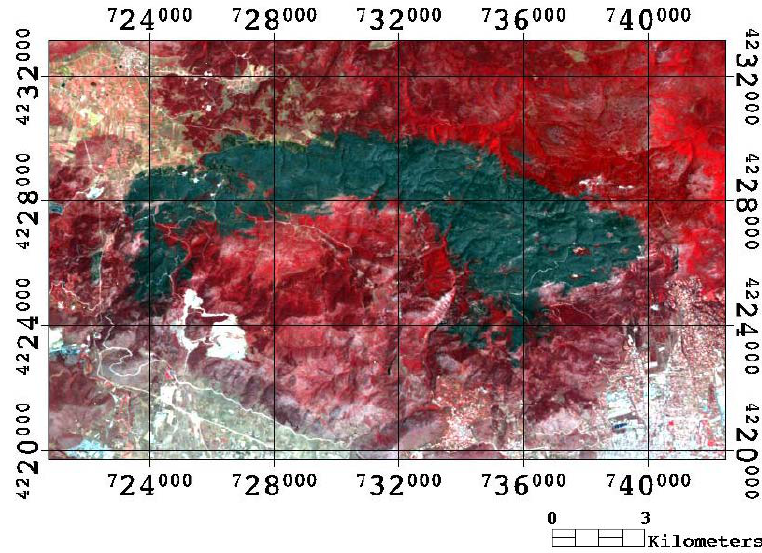
Figure 2. Subset of the Landsat TM post-fire imagery obtained on July 3 rd , 2007 for the study region. The burn scar is shown in